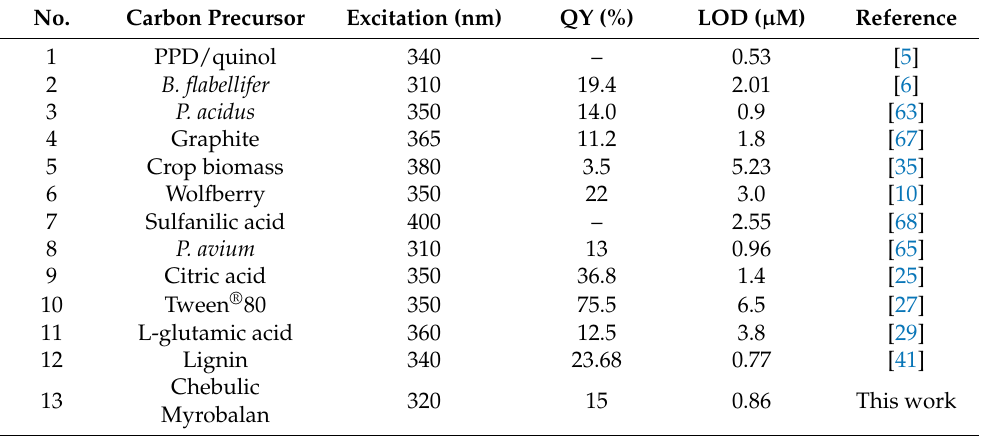
Table 1. Comparison of the fluorescent sensors for the ideal sensing of ferric ions in an aque- ous